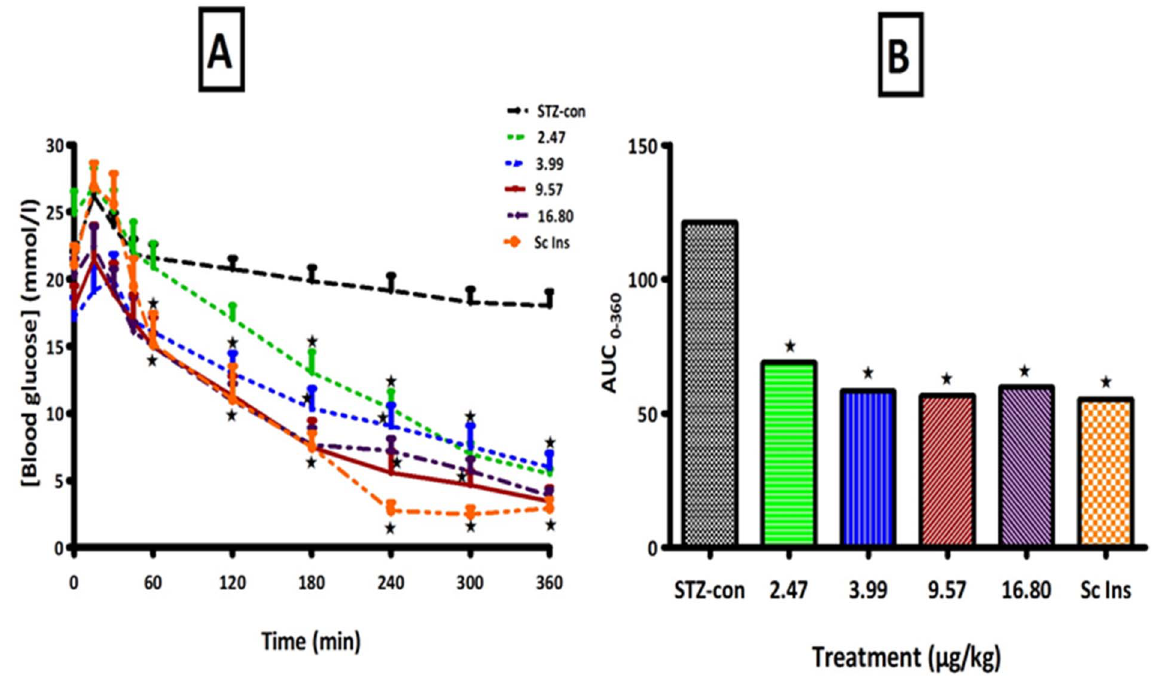
Figure 3. Comparisons of OGT responses (A) and AUC glucose (B) of STZ-induced diabetic rats to PI matrix patches of different insulin concentrations with control animals. Values are presented as means, and vertical bars indicate SEM of means (n=6 in each group). w p , 0.05 by comparison with control animals.